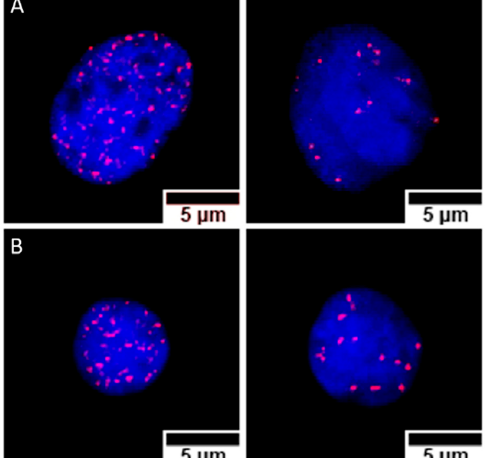
Figure 7. Nuclei from Caco2 ( A ) and SKBR3 ( B ) cells, stained with DAPI (blue), containing γ -H2AX foci immunostained with cyanine 3 (Cy3, red). For both cell lines, nuclei with high (left) and low (right) foci counts are shown. The images correspond to samples prepared 30 min (high foci count) and 4 h (low foci count) after irradiation, treated with anti-EpCam-functionalized GNPs (Caco2) or transferrin-functionalized GNPs (SKBR3).